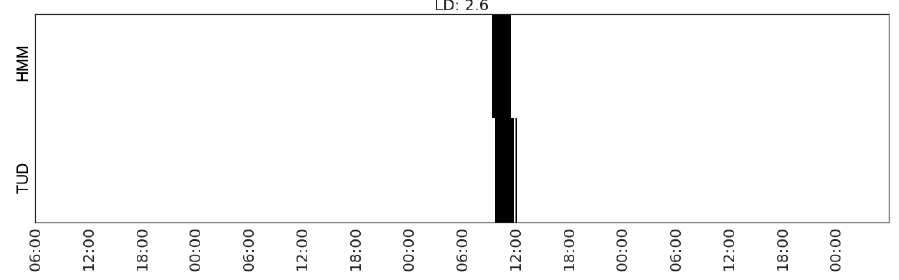
Figure 17. Recognising the activity of doing laundry in Household 3 with feature set (MS_watts_washing-machine, CP_watts_washing-machine).